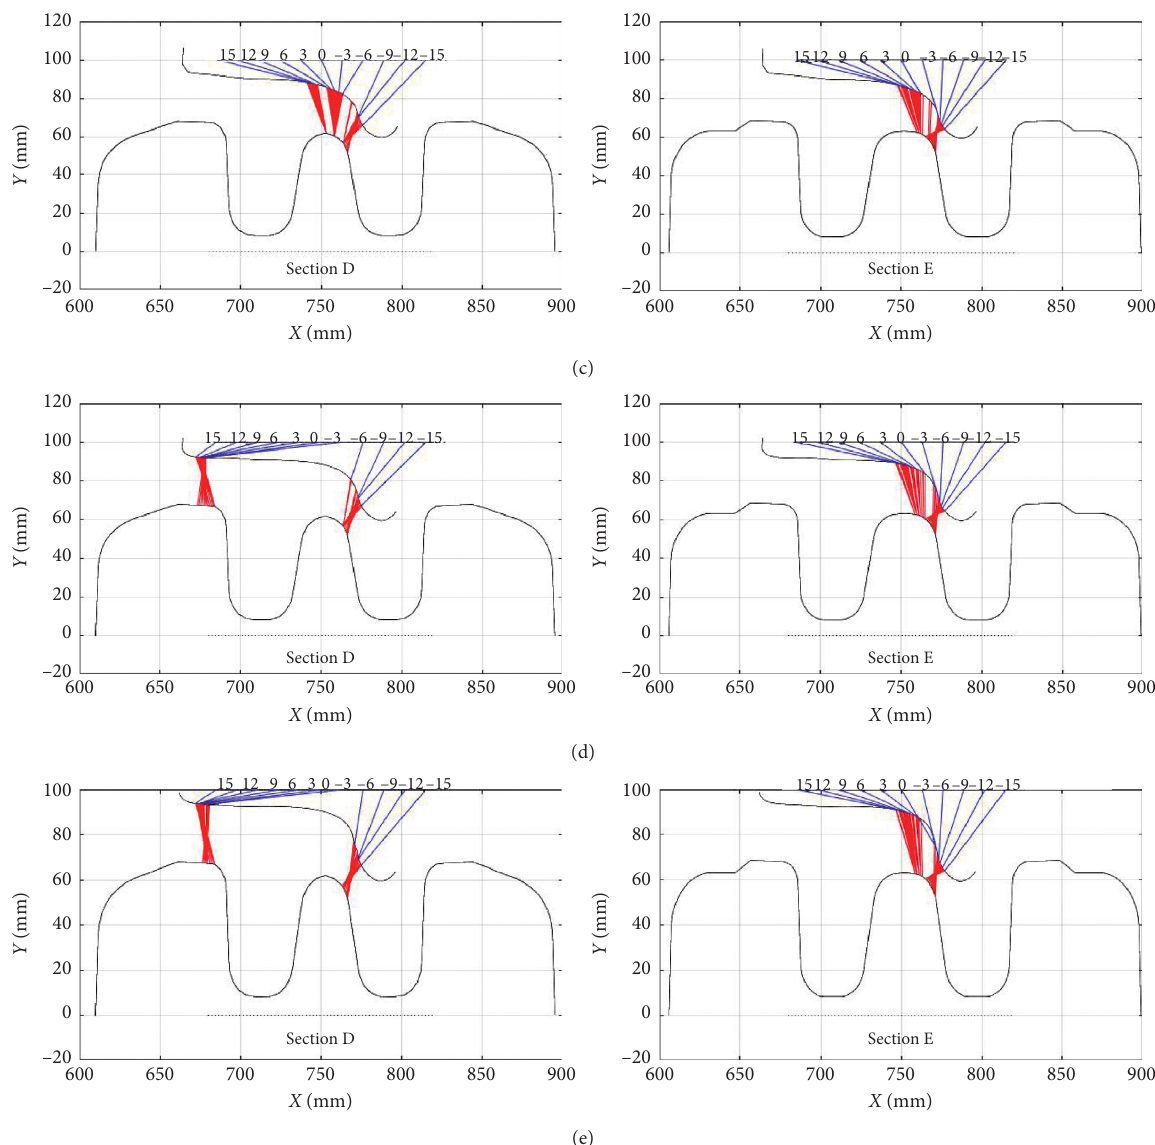
Figure 5: Distribution of wheel-rail contact pairs. (a) Wheel nominal profile. (b) Wheel profile I. (c) Wheel profile II. (d) Wheel profile III. (e) Wheel profile IV.